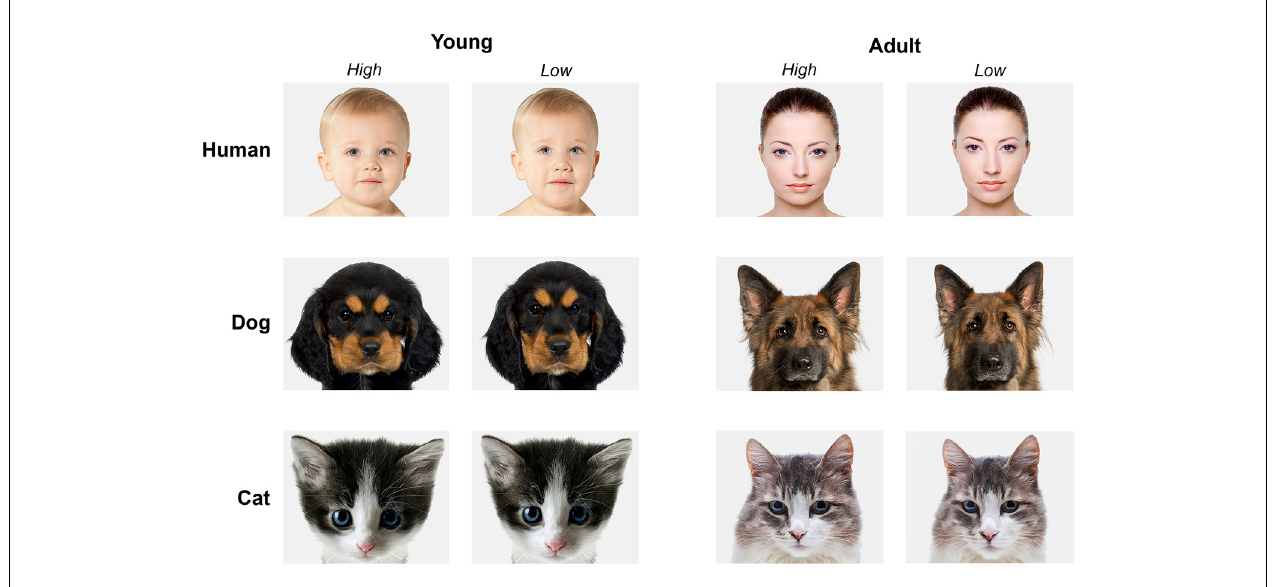
FIGURE 2 | Examples of stimuli presented to participants. Young and adult faces of humans, dogs, and cats. On the left the high infantile version, on the right the low infantile version of the same subject. Photos:Thinkstock/Getty Images